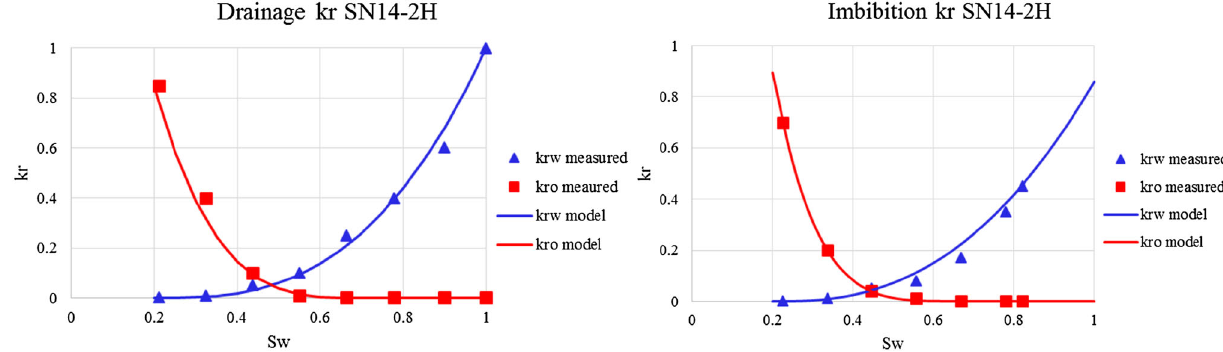
Fig. 25 Drainage and imbibition K r correlation for SN14-2H